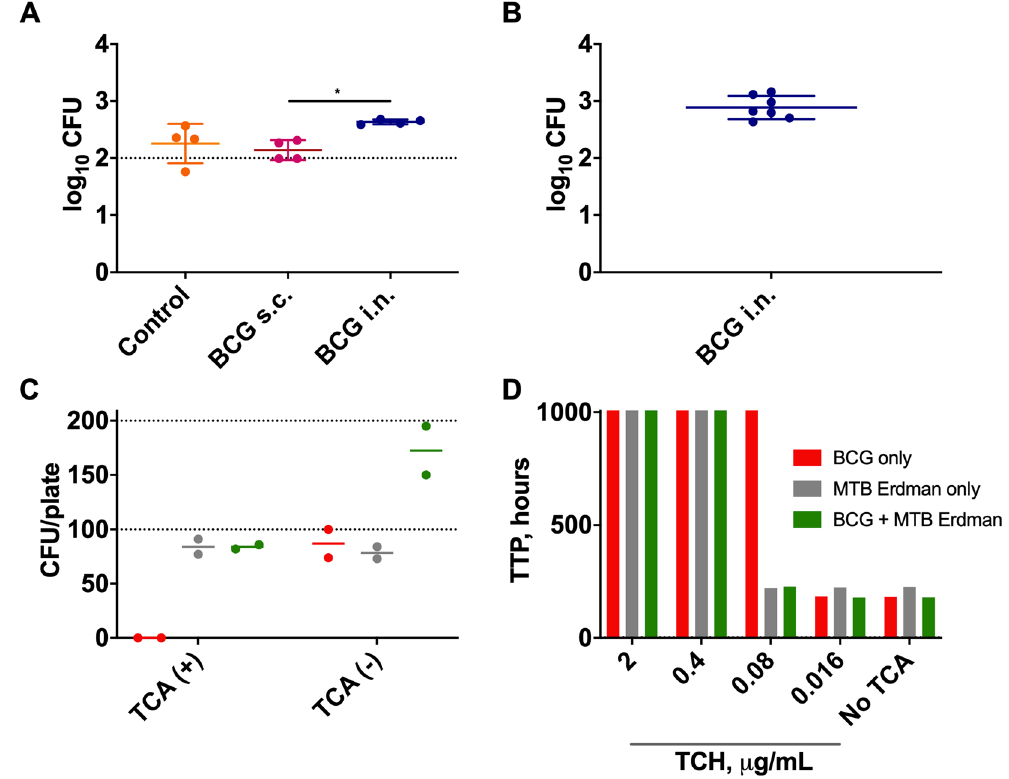
Figure 2. Residual BCG in murine lung cells following intranasal vaccination in the ex vivo MGIA. (A) C57BL/6 mice (n = 6/group) received s.c. or i.n. BCG Pasteur Aeras at week 0 or no treatment (control). At six weeks, 1 × 10 6 lung cells were co-cultured with 100 CFU MTB Erdman in 48-well plates. At 96 hours, samples were transferred to the BACTEC system until TTP values were generated. TTP values were converted to log 10 CFU based on a standard curve. Data points (n = 4/group) represent samples generated from pooled cells from six mice. Statistical significance was tested by one-way ANOVA followed by Tukey’s multiple comparison test. * p < 0.05 (adjusted). (B) Residual BCG in 1 × 10 6 murine lung cells six weeks following immunisation with i.n BCG Pasteur Aeras was quantified using the BACTEC MGIT system. Data points represent four pools of cells from four individual mouse experiments (run as duplicate or single). (C and D) 100 CFU BCG Pasteur Aeras or MTB Erdman, or 100 CFU BCG Pasteur Aeras and 100 CFU MTB Erdman were: (C) plated on 7H11 agar plates in the presence or absence of 2 μ g/mL TCH to confirm the inhibitory properties of TCH on BCG only (n = 2/ condition); (D) added to MGITs in the absence or presence TCH (five-fold serial dilutions of 2 μ g/mL stock: 0.4, 0.08, 0.016 μ g/mL) to determine the optimal concentration of TCH to inhibit BCG growth only (n = 1/ condition) in the BACTEC system. A TTP value of 1,008 hours (42 days) indicates a negative result (no bacteria detected). Dotted lines indicate mycobacterial input. Error bars represent mean ± standard deviation. ANOVA, analysis of variance; BCG, Bacille Calmette-Guérin; CFU, colony-forming units; i.n., intranasal; MGIA, mycobacterial growth inhibition assay; MGIT, mycobacterial growth indicator tube; s.c., subcutaneous; TCH, 2-thiophenecarboxylic acid hydrazide; TTP, time to